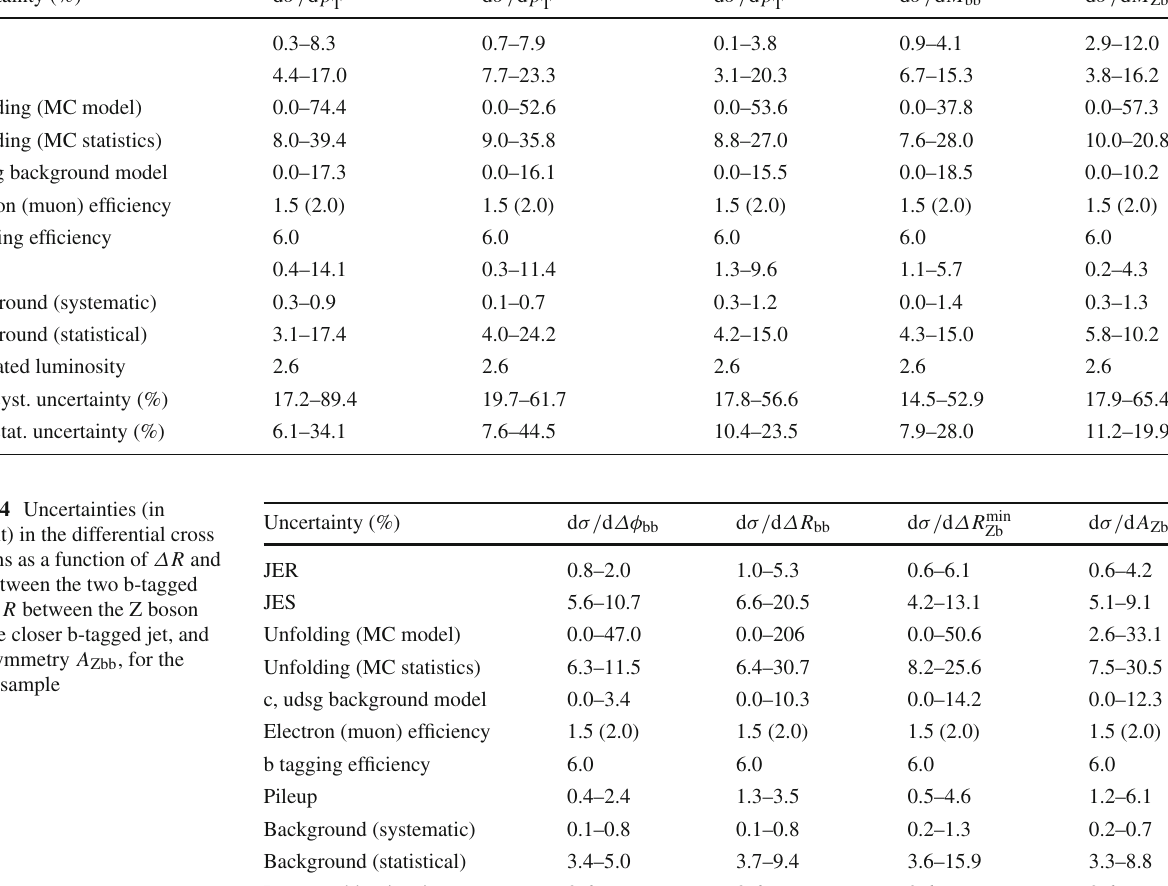
Table 3 Uncertainties (in percent) in the differential cross sections as a function of the leading and subleading b jet p T , the Z boson p T , the invariant mass of the two b-tagged jets, and the invariant mass of the Z boson and the two b-tagged jets, for the Z ( 2b ) sample Uncertainty (%)